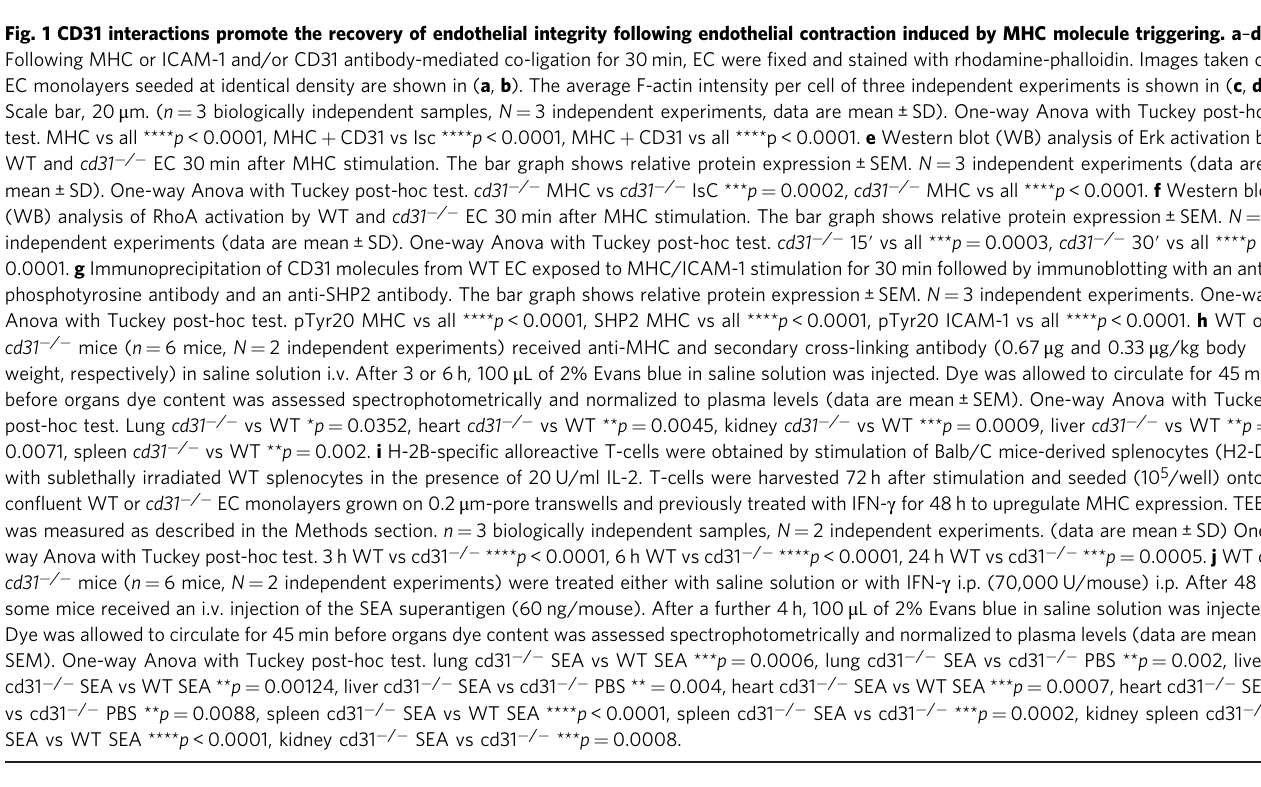
(Supplementary Fig. 2c, d). Conversely, tyrosine-663 but not -686 was instrumental for CD31 intracellular traf fi cking 28 , suggesting that the two ITIMs may differentially contribute to distinct CD31 functions. The role of CD31 was further con fi rmed in experi-